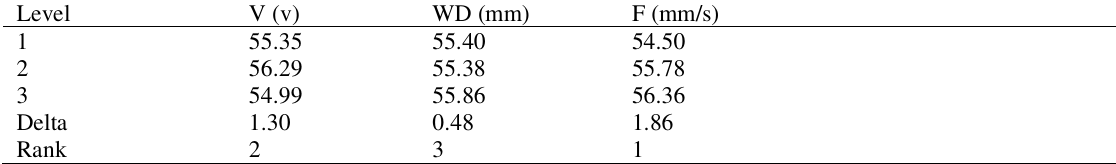
Response Table for s/n of